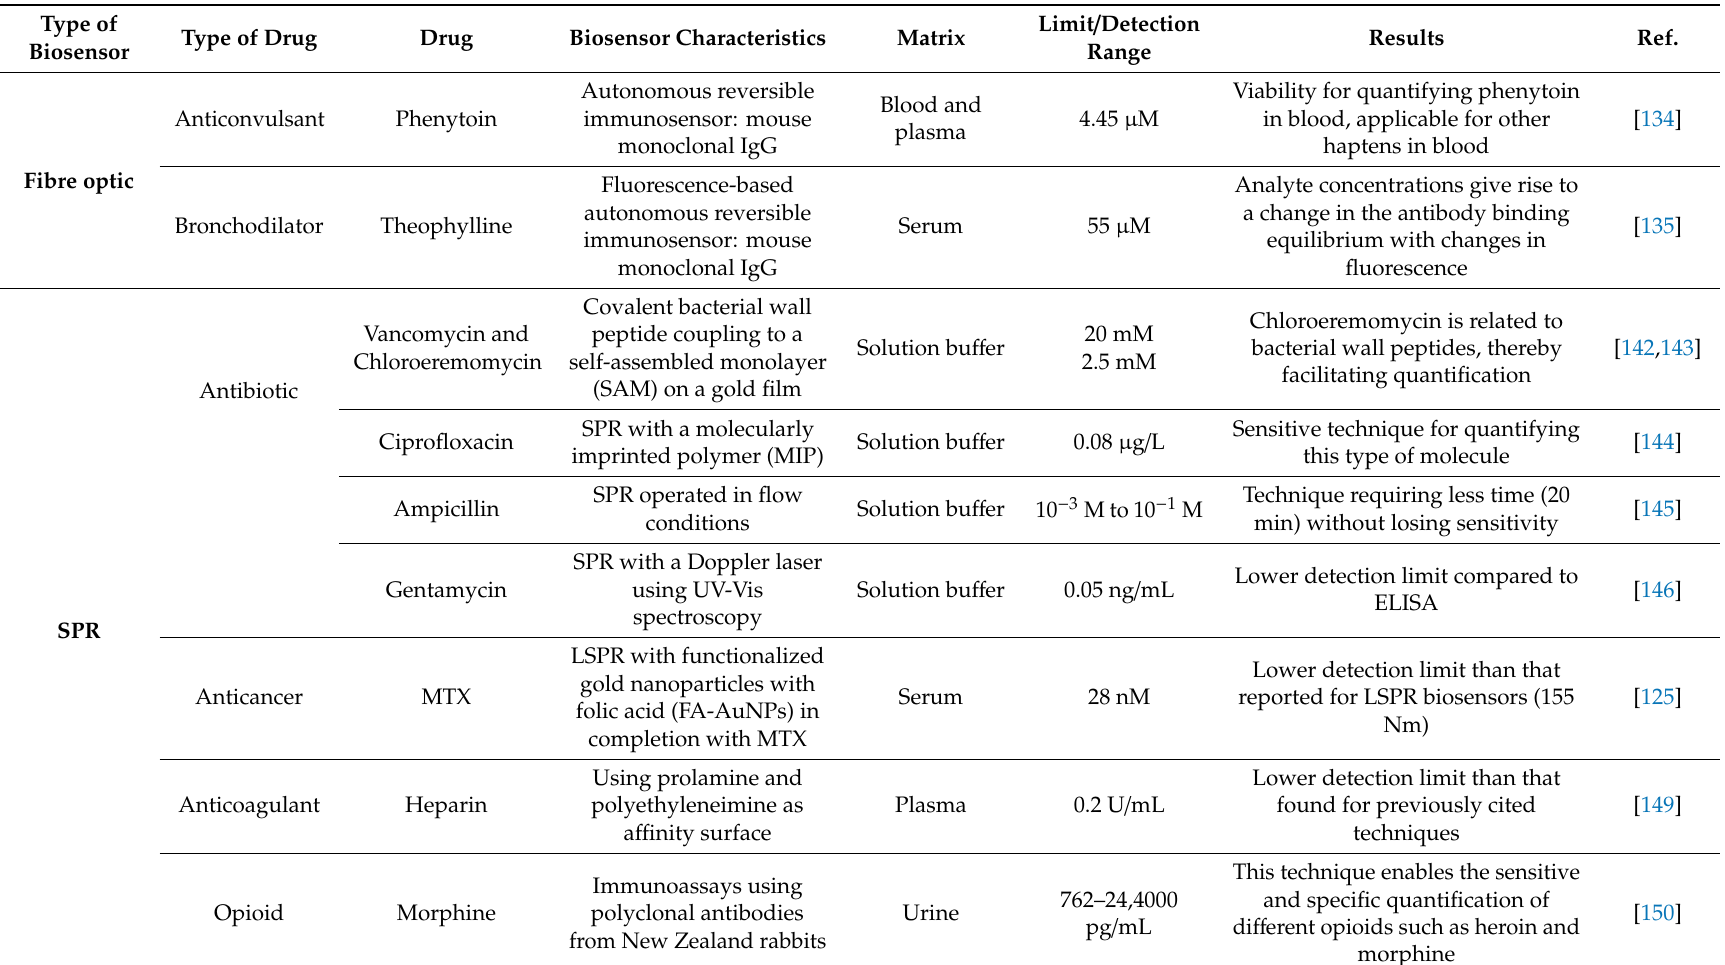
Table 2. Therapeutic drug monitoring using optical